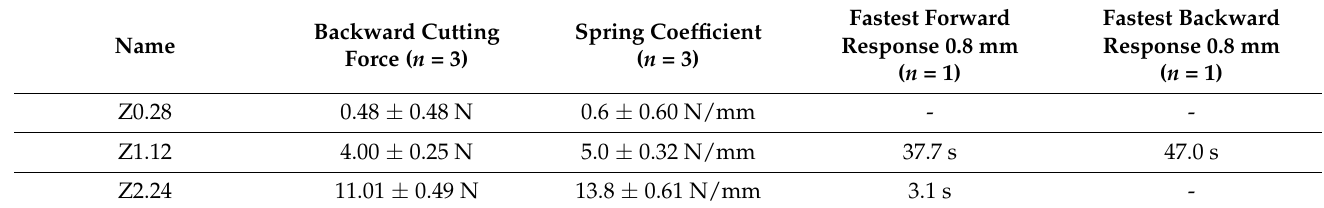
Table 4. Results of the spring diaphragm tests, showing the backward cutting force, spring coefficient, fastest forward response for 0.8 mm displacement, and fastest backward response for 0.8 mm dis- placement. If no values are given, the prototypes were unable to fulfill the entire 0.8 mm displacement due to leakages occurring before the test could be completed.